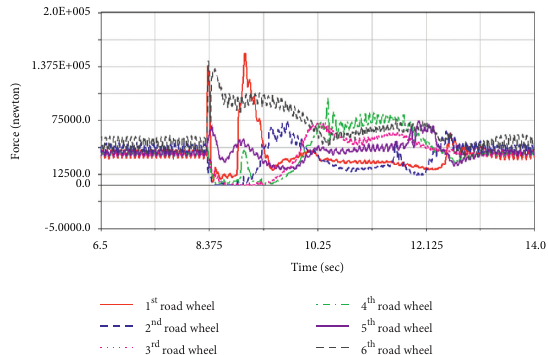
Figure 16: Vertical load of each load wheel in the process of crossing a vertical